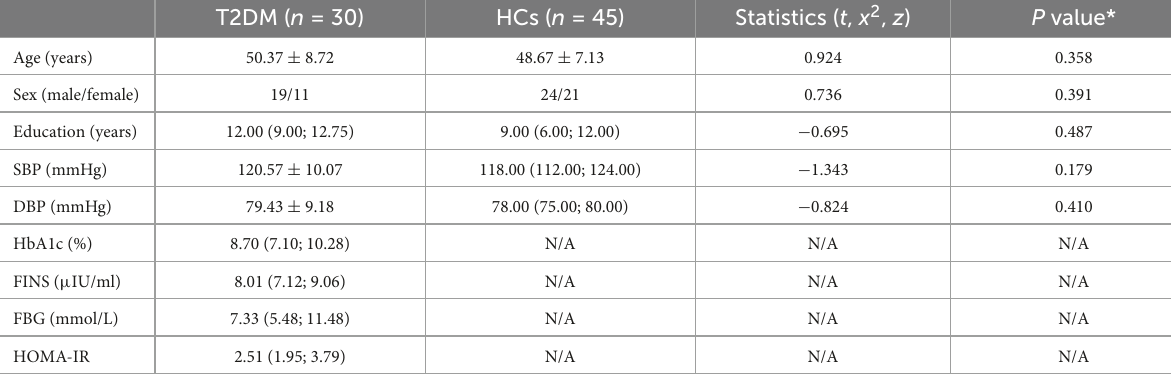
TABLE 1 Demographic data and clinical biochemical indicators of all subjects.